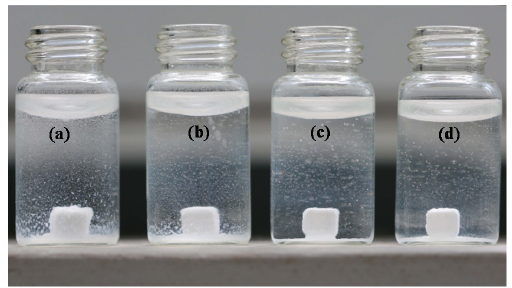
Figure 5. Disintegration of the specimens with different amounts of 45S5 bioglass after soaking in